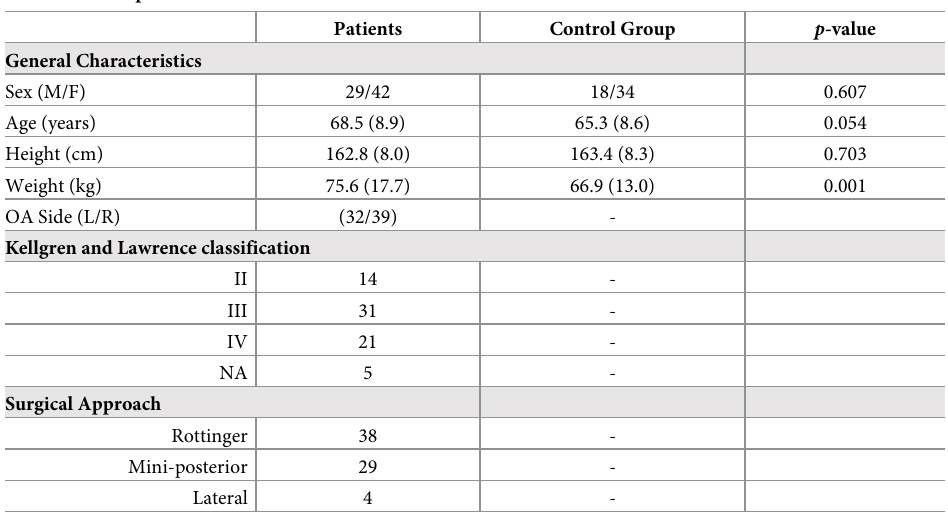
Table 1. Participants’